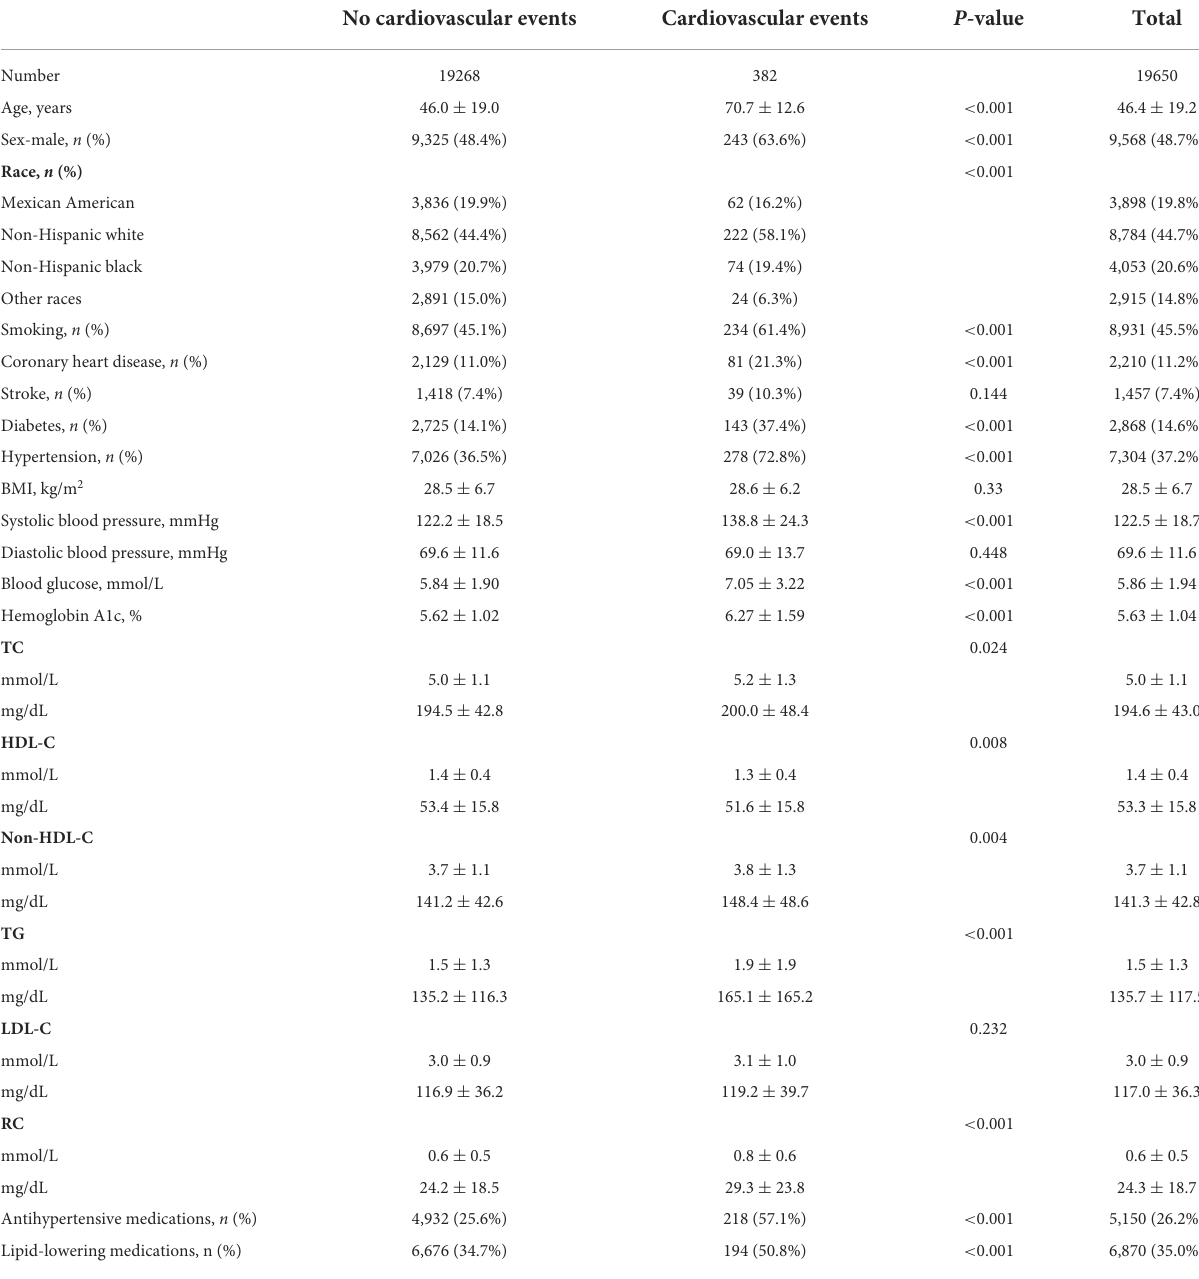
TABLE 1 Baseline characteristics of the study